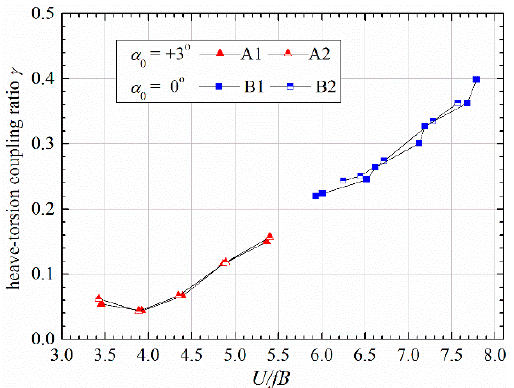
Figure 9. Heave-torsion coupling ratio versus reduced wind speed in post-critical state.